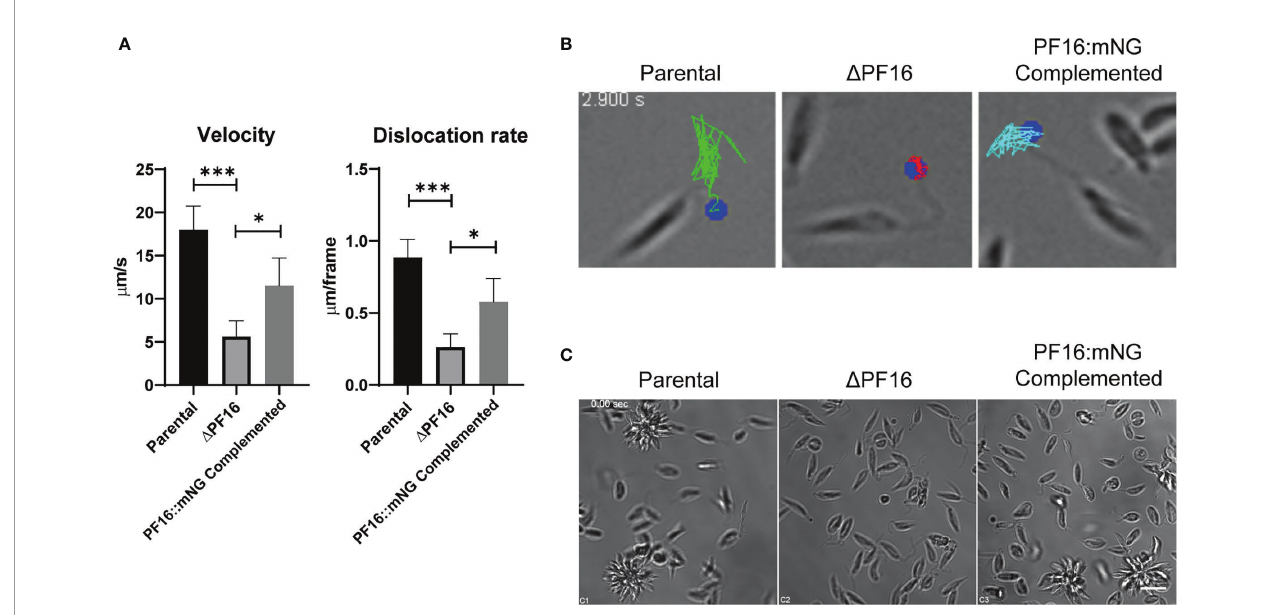
FIGURE 7 | Phenotypic characterization of parental, PF16 knockout, and complemented lines. (A) Parasites were seeded in microscopy slides and imaged at 20 frames per second. Flagella tip was tracked in individual parasites, and mean velocity and dislocation rates per frame were estimated for parental (Lb C9/T7), knockout (Lb C9/T7 D PF16), and complemented (Lb C9/T7 PF16::mNG) lines. Each graph bar represents the mean ± SD of 15 parasites evaluated in four to fi ve focal fi elds. * p < 0.05, *** p < 0.0003. (B) Trajectory of the tip of the fl agella (dot — fl agella tip, white line — overlay of the tracked paths). Scale bar 5 µm. For the movie fi le, see Supplementary Video 2 . (C) Filming each cell line revealed the presence of the fl agella and unchanged morphology of genetically modi fi ed cell lines. Motility was impaired in knocked out parasites compared with the parental line, and parasites remained at the same place all over the acquisition. In complemented and in parental lines, it was possible to see swimming parasites entering the focal fi eld occasionally. Scale bar 10 µm. For movie fi les, see Supplementary Video 1